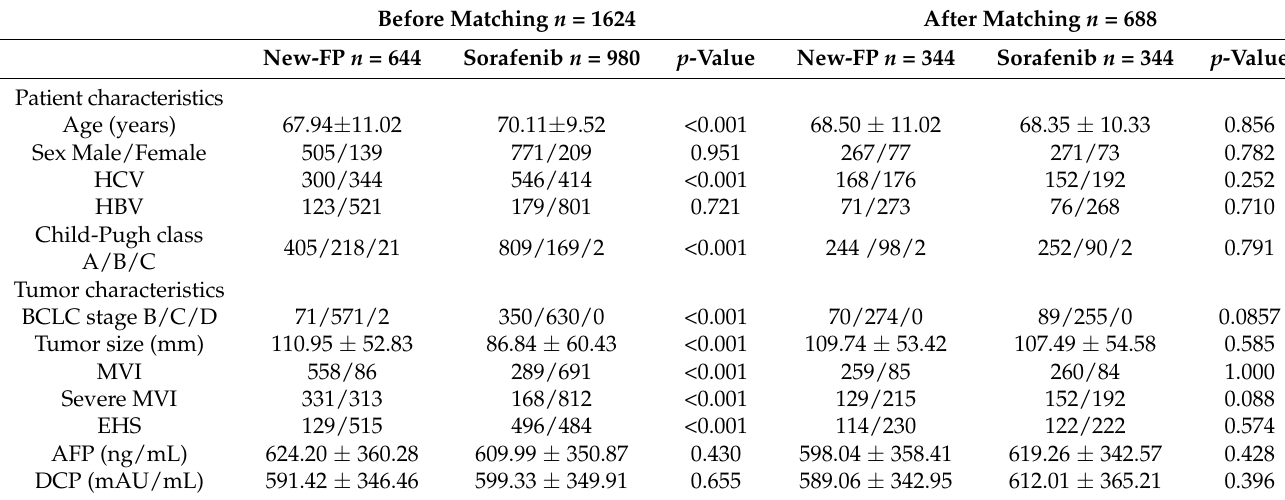
Figure 2. Flow diagram of the study. Abbreviations: MVI, macrovascular invasion; EHS, extrahepatic spread. Table 1. Patient and Tumor Characteristics Before and After Propensity Score Matching.